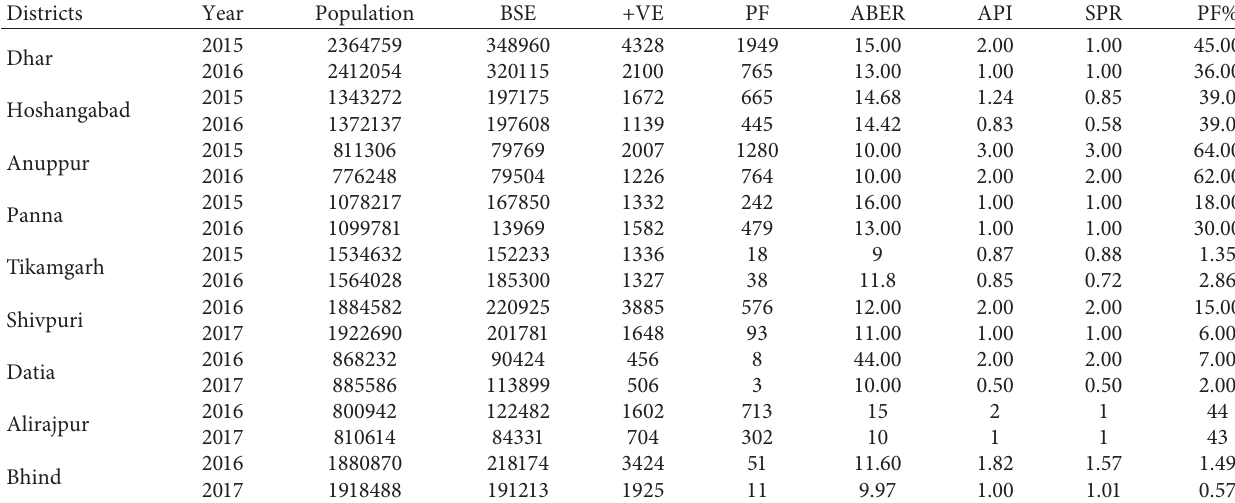
Table 1: Epidemiological situation in the districts selected for the insecticide monitoring study. Districts